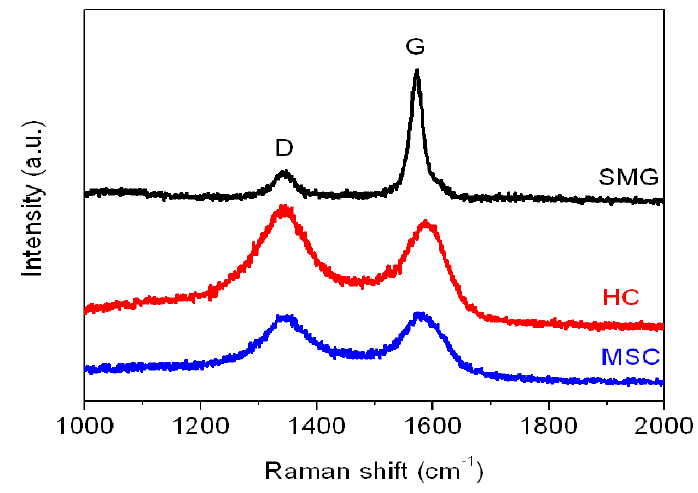
Figure 4. Raman spectra plot of SMG, HC, and MSC anode